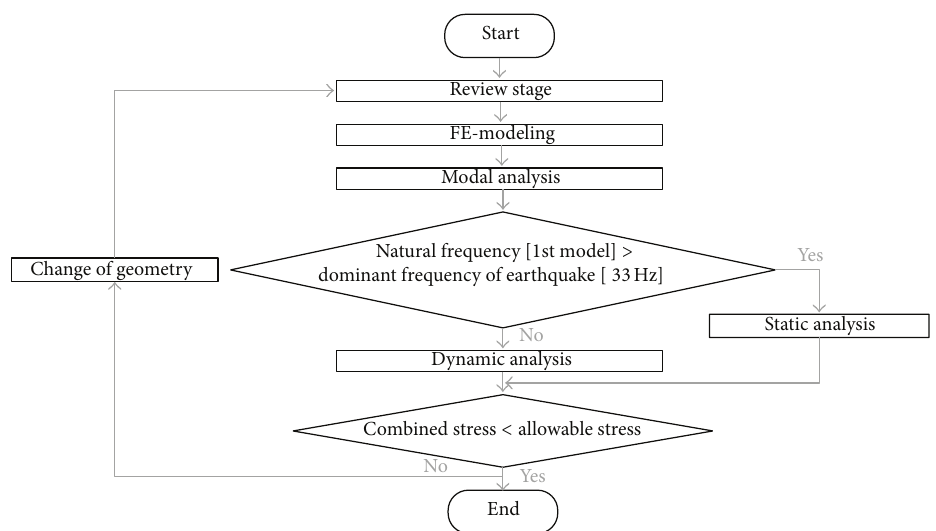
Figure 2: Flow chart of performance assessment using numerical